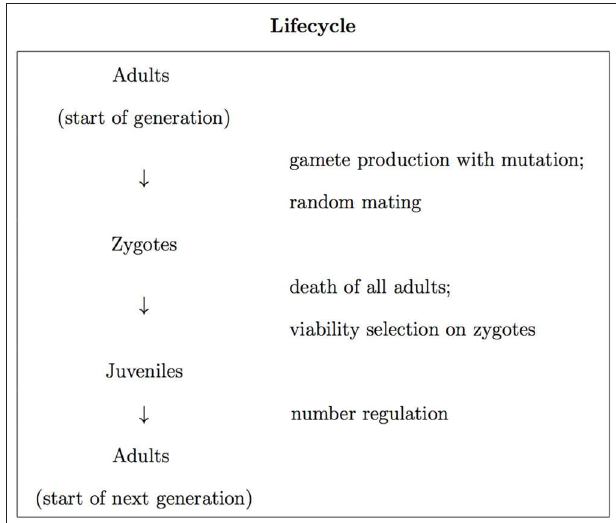
FIGURE 1 | The discrete-generation lifecycle employed in this work.